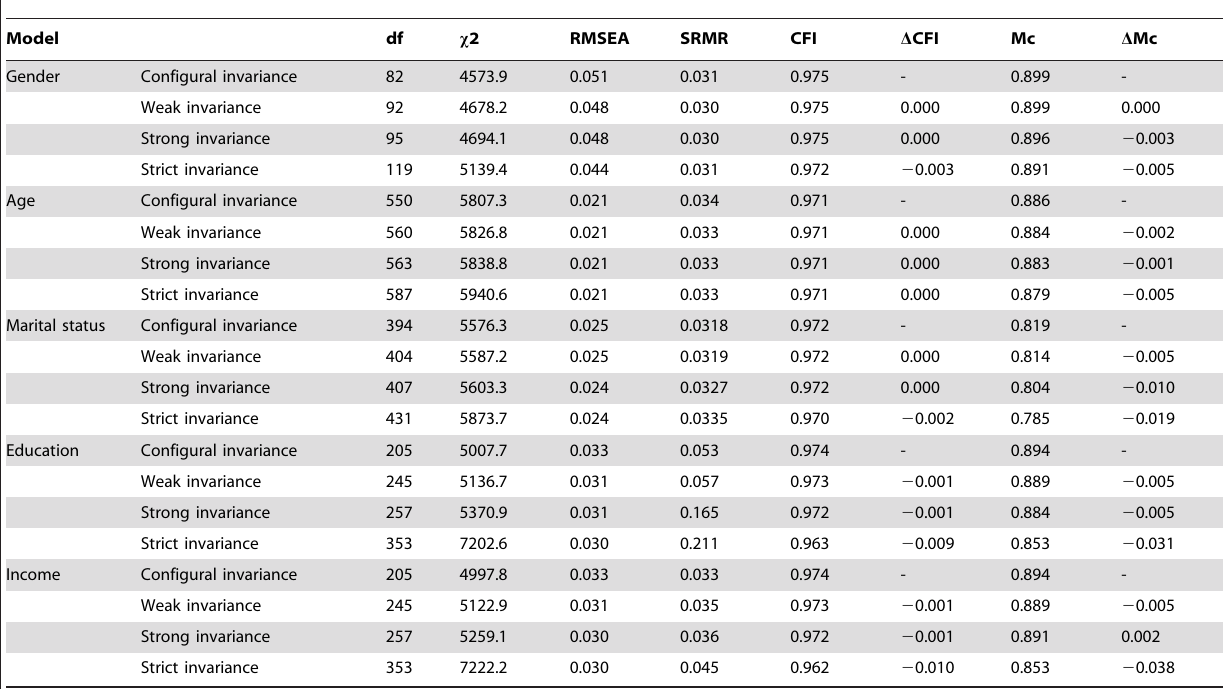
Table 4. Model fit of various invariance models for gender, age, education level and income groups.